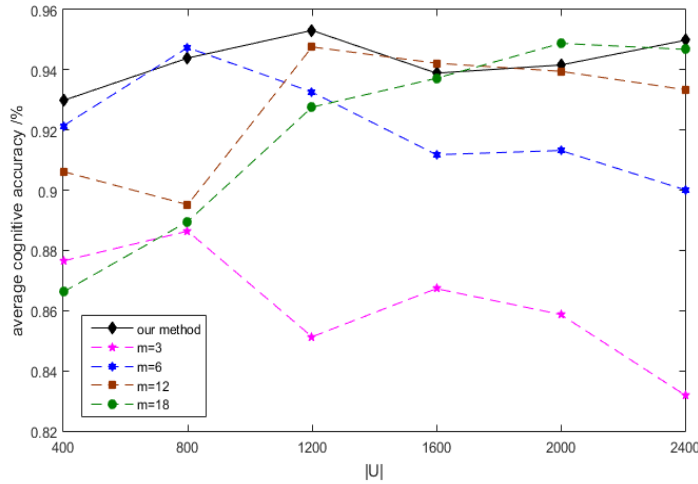
Figure 6. Average cognition accuracy vs. different training dataset domain |𝑈| .